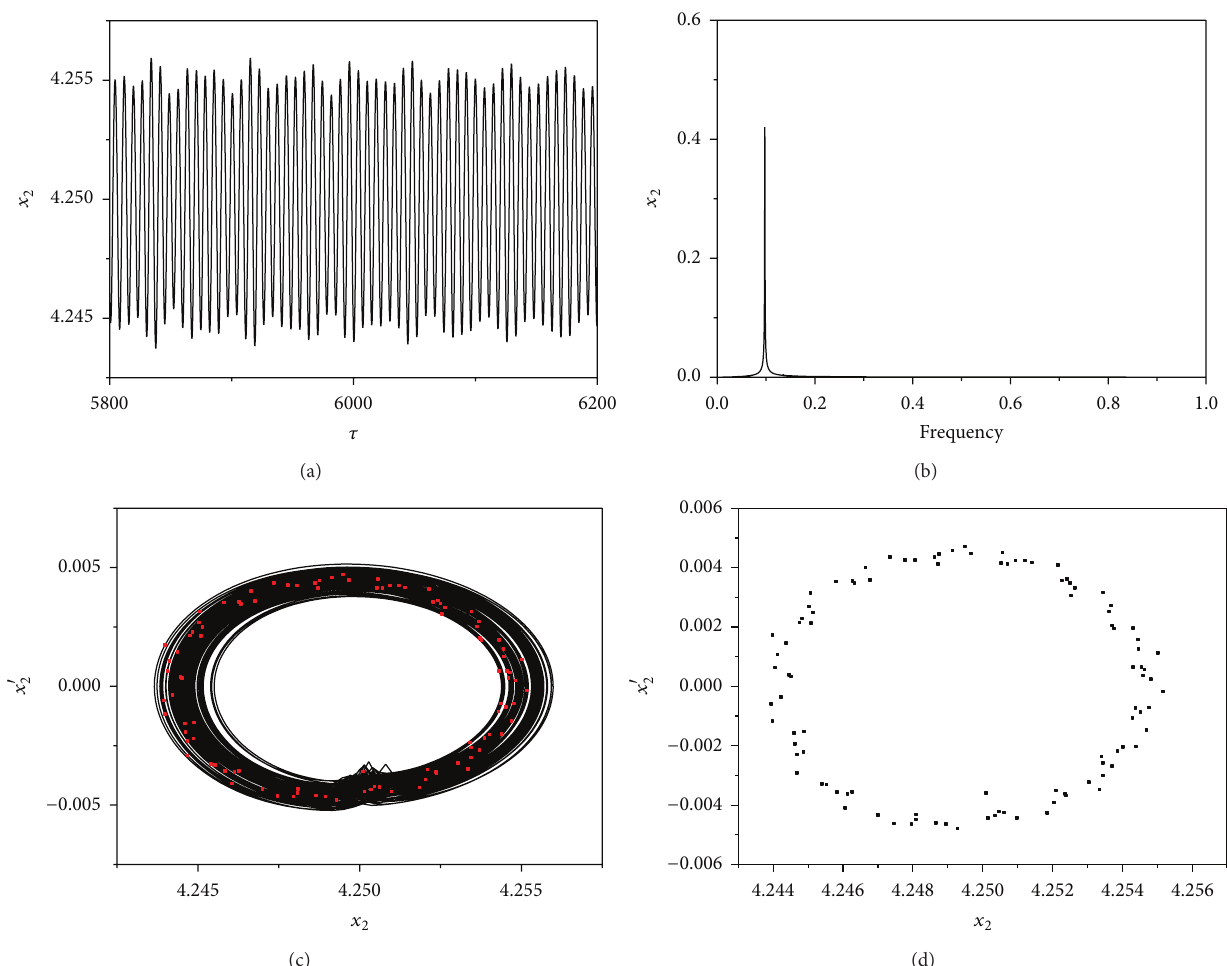
Figure 16: See 𝜔 = 0.80 . (a) Displacement response. (b) Frequency spectrum. (c) Phase-portrait plots. (d) Poincar´e